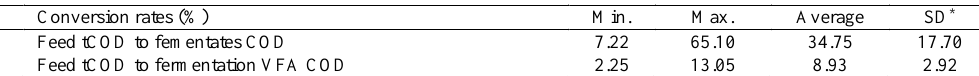
Table 4: Conversion